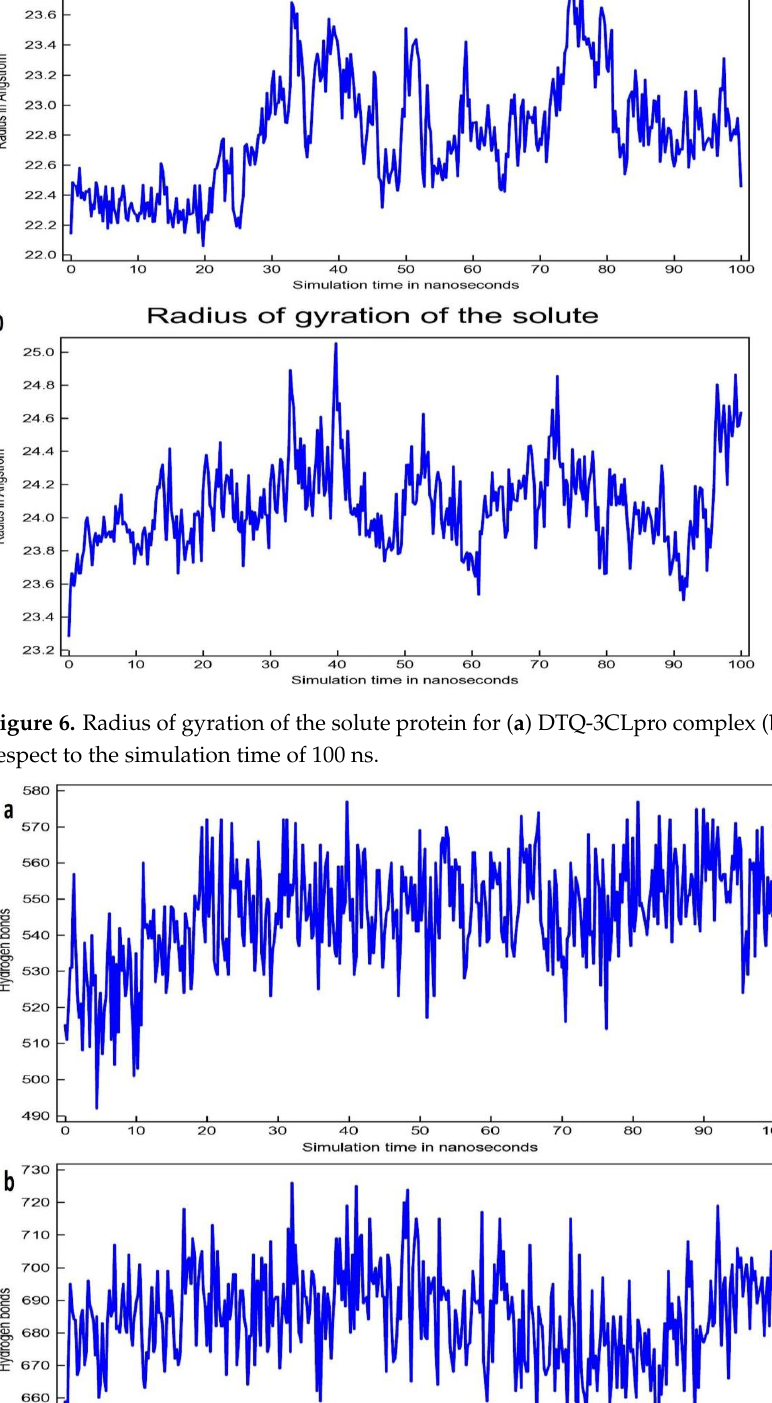
Figure 7. Number of hydrogen bonds for (a) DTQ-3CLpro complex and (b) DTQ-NSP15 with respect to the simulation time of 100 ns. .